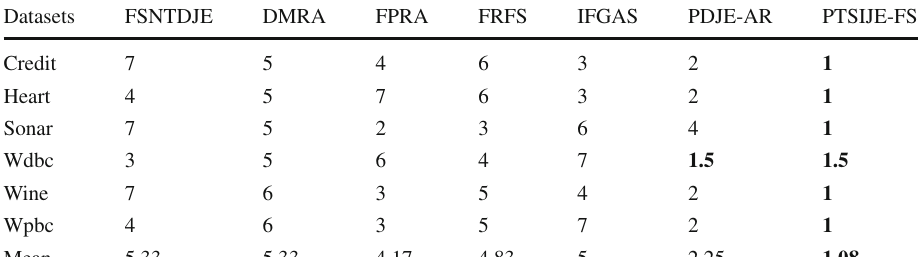
Table 12 Rank of the seven methods with CART